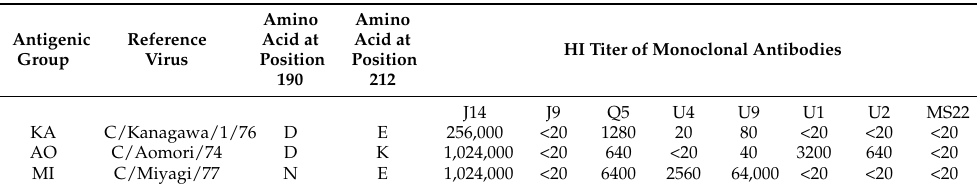
Figure 2. Population dynamics of genetic diversity of each lineage of the influenza C virus. The relative genetic diversity of each lineage of the influenza C virus using the Gaussian Markov random field (GMRF) model. Data are shown after 1985 because few sequences were available before that year. No plots for the C/Aichi lineage and the C/Taylor lineage are presented because of the paucity of sequence data. Table 1. Antigenic groups of the C/Kanagawa lineage.